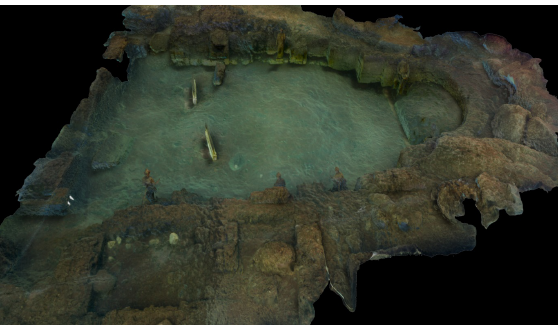
Figure 5. Textured 3D model of the “Nymphaeum of Punta Epitaffio” after the dredging operations (19 million polygons).